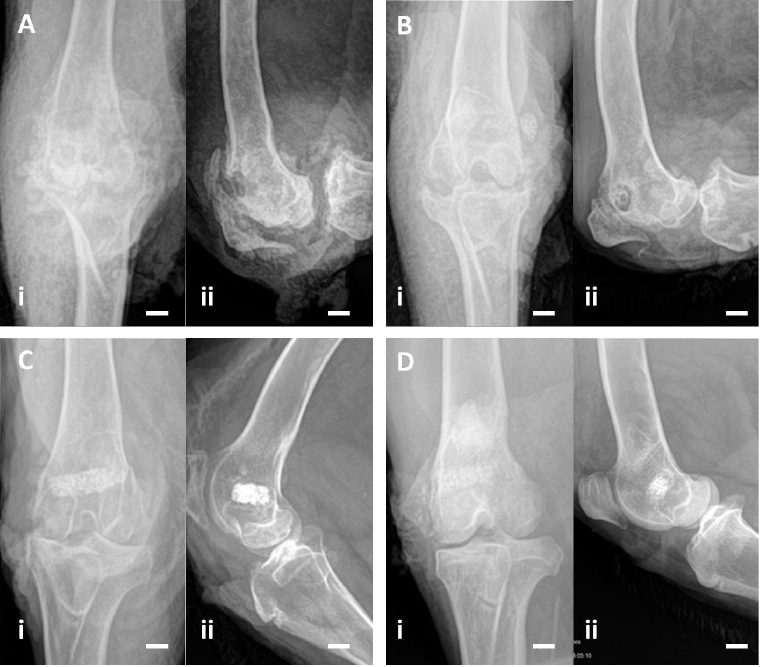
Figure 4. ( A ) In Group A animals, where the osteomyelitis was not treated, an irregular bone cavity is visible, associated with joint destruction. ( B ) In Group B animals, where HEPHAPC was placed (without vancomycin), the biomaterial is surrounded by a radiolucent halo. In some places, the biomaterial is visible outside the cavity initially created, demonstrating its non-integration. ( C ) In Group C animals, implanted with V-HEPHAPC, the biomaterial is integrated, without a radiolucent halo and without extravasation, very similar to the images of Group D. ( D ) In the animals in which the biomaterial was implanted without previous infection (Group D), there is no radiolucency around the implant, showing osseointegration. Scale bar = 1 cm, ( i ) Frontal view; ( ii ) Lateral view of the